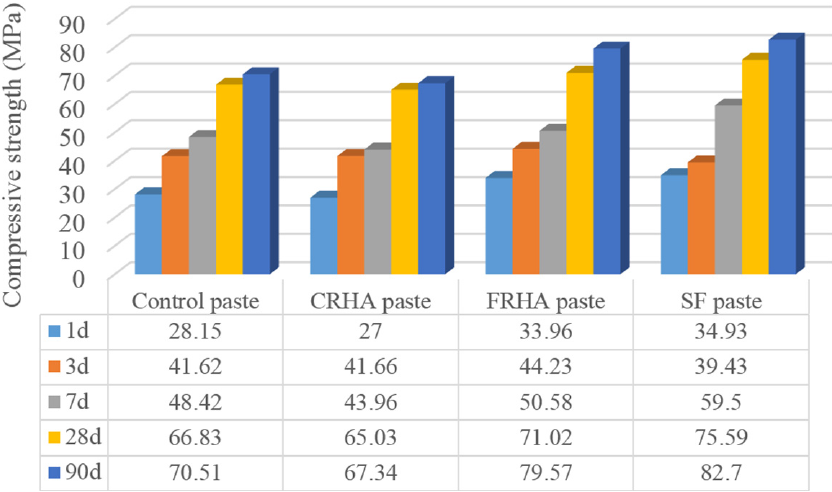
Figure 3. Compressive strength of pastes.